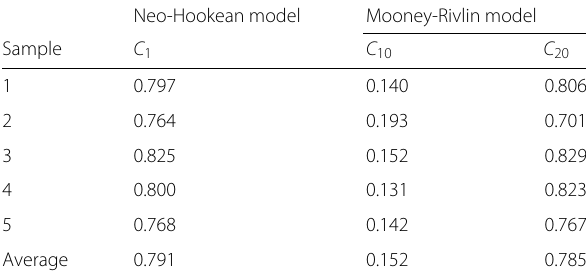
Table 2 Material parameters [MPa] for the Neo-Hookean